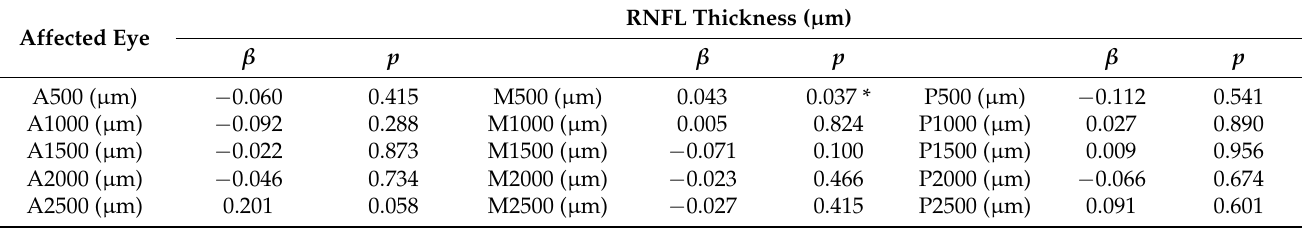
Table 4. Univariate linear regression of associations of iris thickness and RNFL thickness in PSS- affected eyes.